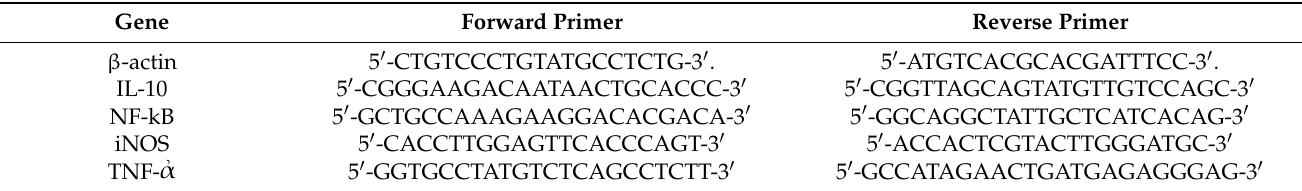
Table 1. Primer sequences for RT-qPCR which used were as follows.